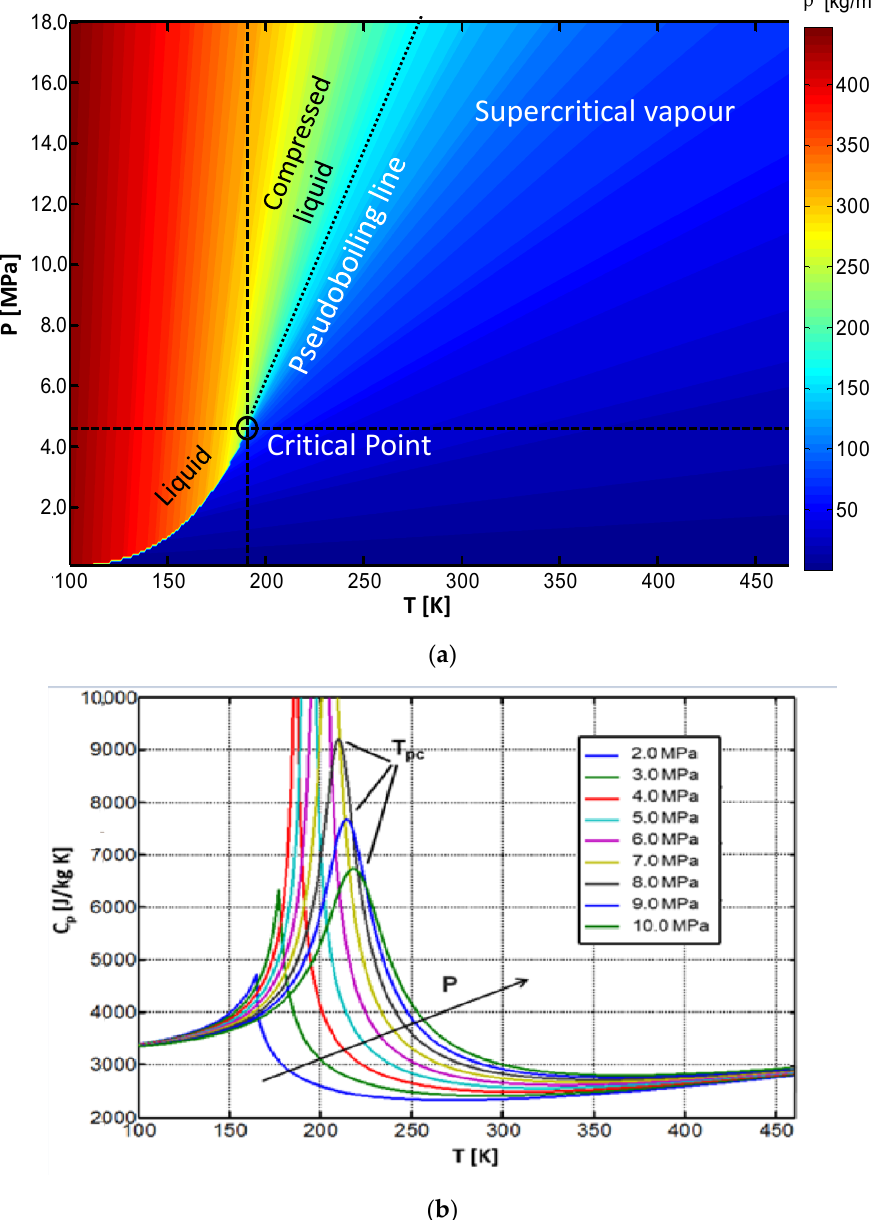
Figure 5. Methane thermo-physical properties, as a function of temperature and pressure: ( a ) density (kg/m 3 ); ( b ) specific heat (J/kg K).